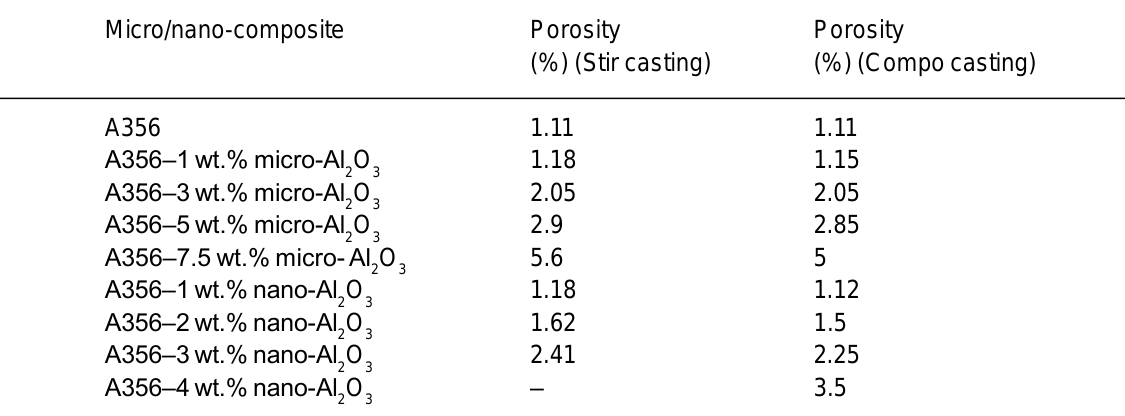
Table 2 . The porosity percent of micro and nano-composite fabricated by compo and stir casting process data from [45].